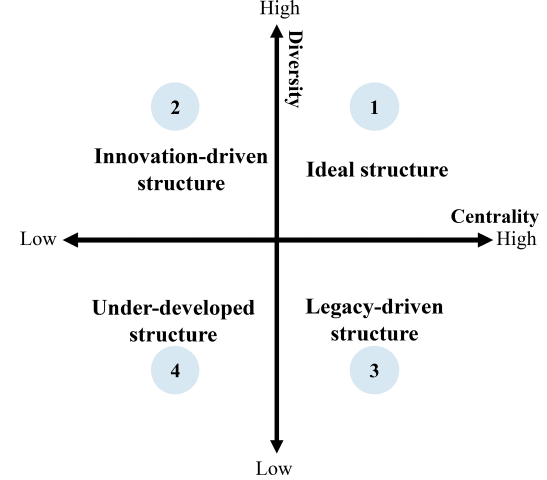
Figure 1. Definition of four knowledge structures based on their structural